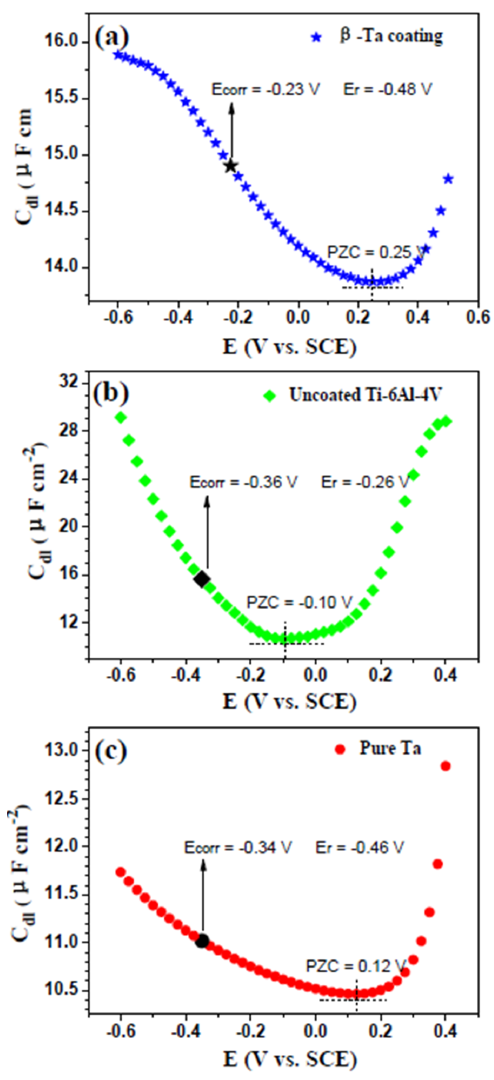
Figure 7. Double layer capacities as a function of the applied potential for ( a ) the β -Ta coating; ( b ) uncoated Ti-6Al-4V and ( c ) commercially pure Ta in Hank’s solution at 37 °C.